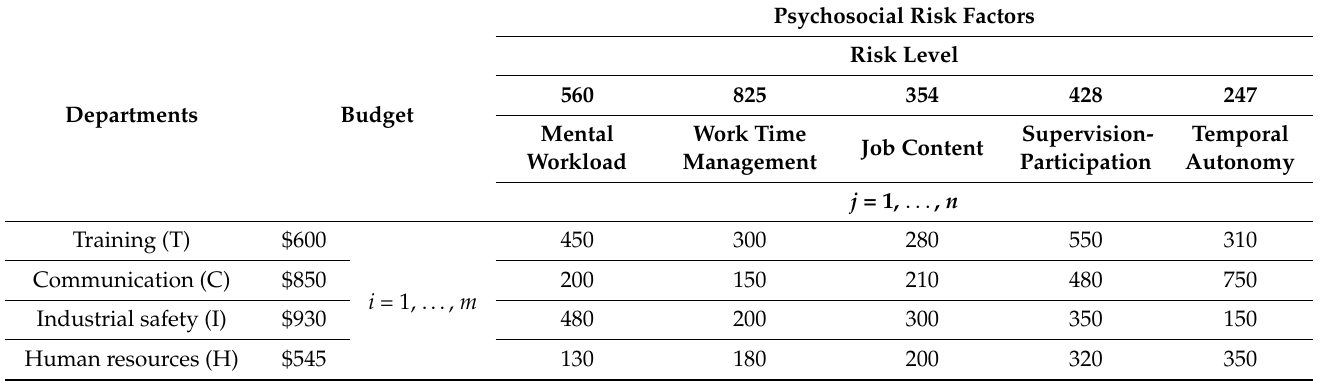
Table 3. CASE-1. Cost for each department in each aspect of risk.